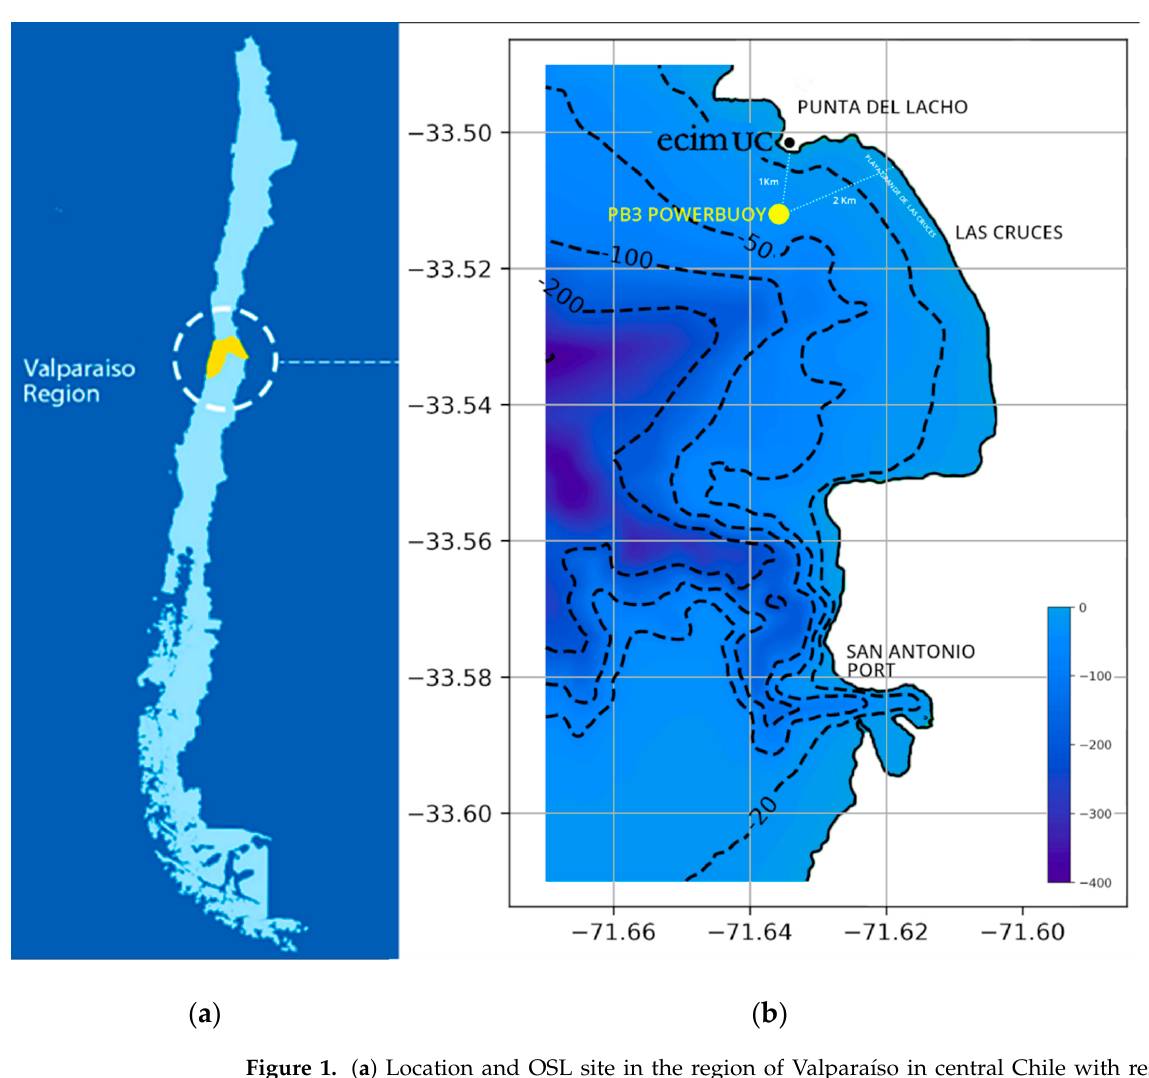
Figure 1. ( a ) Location and OSL site in the region of Valparaíso in central Chile with respect to the boundaries of the country at the western coast of the continent. ( b ) View of the bathymetric description of the bay, indicating the latitude and longitude of the site.